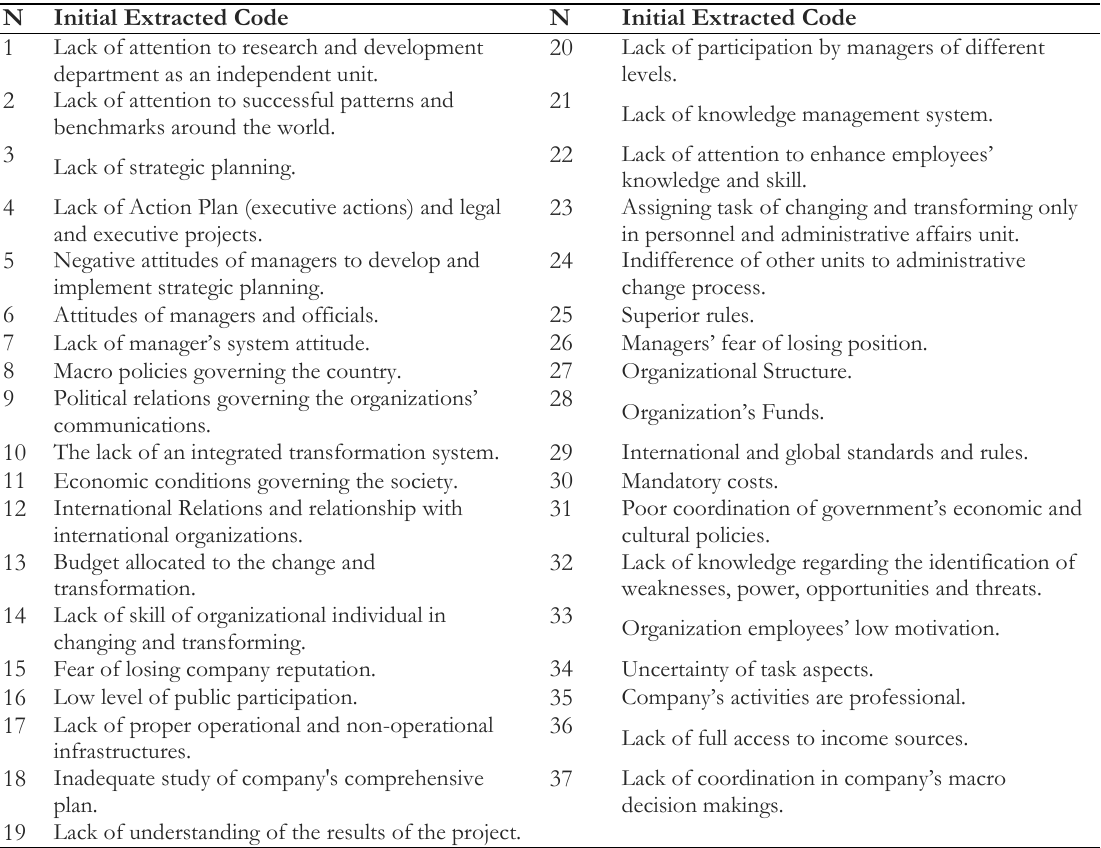
Table 4. Extracted codes related to barriers.